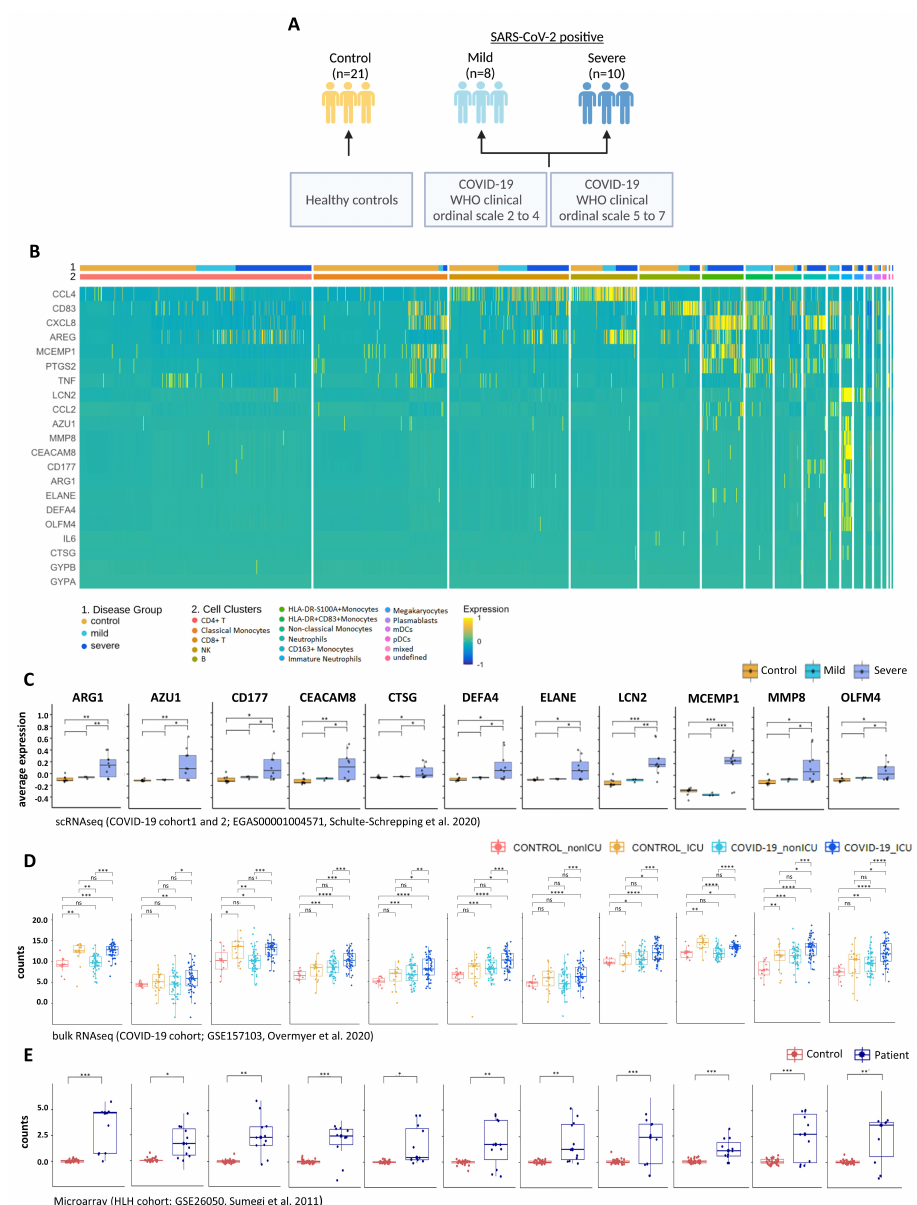
Figure 6. Multi-layered transcriptomic analysis associates neutrophil activation signature with COVID-19 severity. ( A ) Schematic overview of sample cohort and classification of scRNA seq dataset obtained by Schulte-Schrepping et al. [29] and used for the following analysis. Created with BioRender.com. ( B ) Heatmap showing scRNA seq expression of differentially expressed genes (DEGs) associated with disease severity. Cells and cohorts (controls, mild and severe COVID-19) are indicated by different colors in the legends. ( C ) Box plots of scRNA seq expression demonstrating that 11 of the 21 genes identified in ( B ) are up-regulated when comparing severe and mild COVID-19 patients. ( D ) Box plots of the 11 genes stratifying COVID-19_ICU patients from COVID-19_nonICU patients obtained from the bulk-RNA seq dataset from Overmyer et al. [26]. Significant differences between groups are indicated by asterisks (* p ≤ 0.05, ** p ≤ 0.01, *** p ≤ 0.001 and **** p < 0.0001). ( E ) Box plots of microarray data illustrating that the disease severity association of COVID-19 detected by scRNA seq corresponds to the expression differences of these genes between HLH patients and controls obtained from the dataset published by Sumegi et al. [30]. Significant differences between groups are indicated by asterisks (* p ≤ 0.05, ** p ≤ 0.01 and *** p ≤